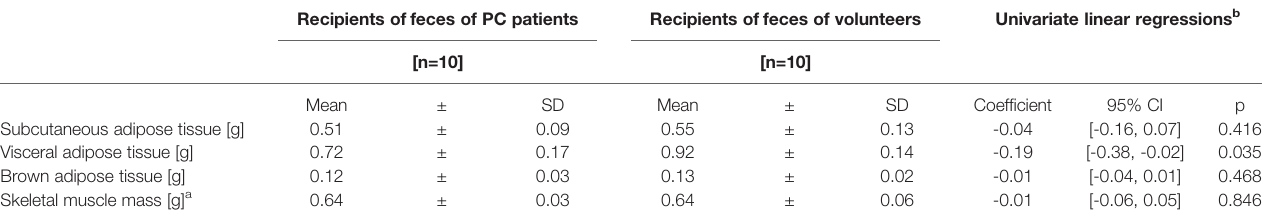
TABLE 2 | Body composition of mouse recipients at sacri fi ce.